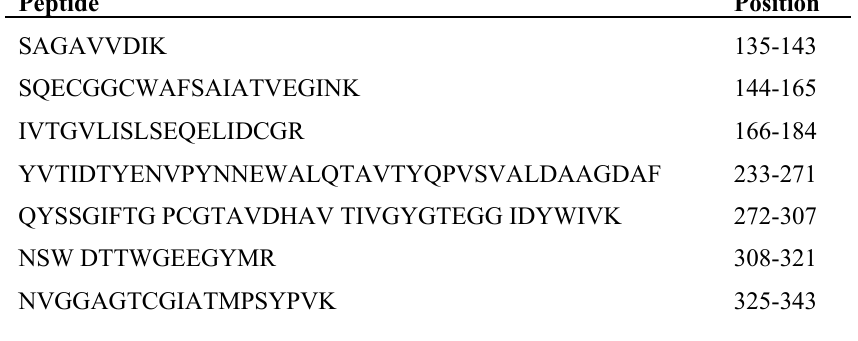
Table 2. Summary of peptide positions from Act d